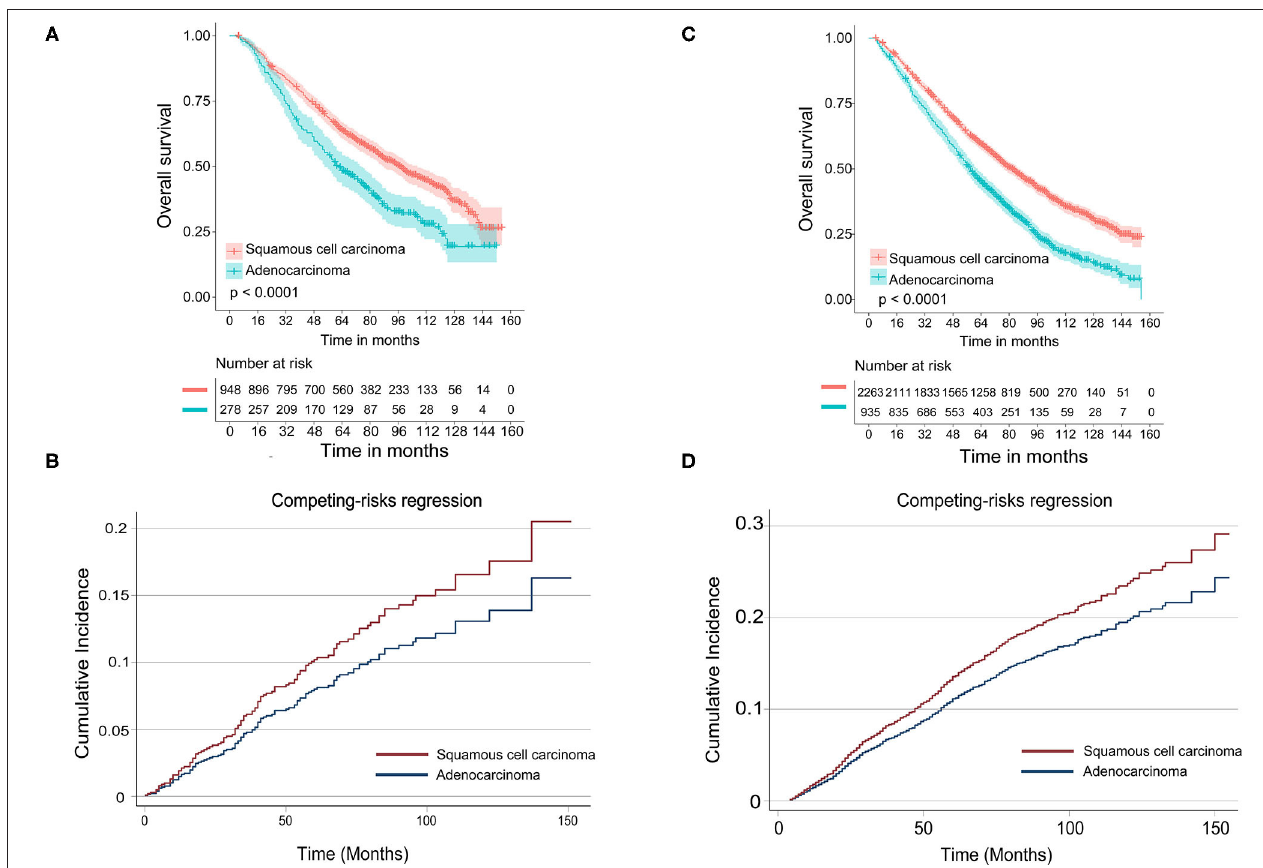
FIGURE 2 | Survival analyses for stage IA NSCLC patients aged 70 and older stratified by tumor size. (A) Kaplan–Meier estimates for overall survival by histological subtype of patients with tumor size ≤ 10mm; (B) cumulative incidence for lung cancer-specific mortality by histological subtype of patients with tumor size ≤ 10mm; (C) Kaplan–Meier estimates for overall survival by histological subtype of patients with tumor size > 10 and ≤ 20mm; (D) cumulative incidence for lung cancer-specific mortality by histological subtype of patients with tumor size > 10 and ≤ 20mm.